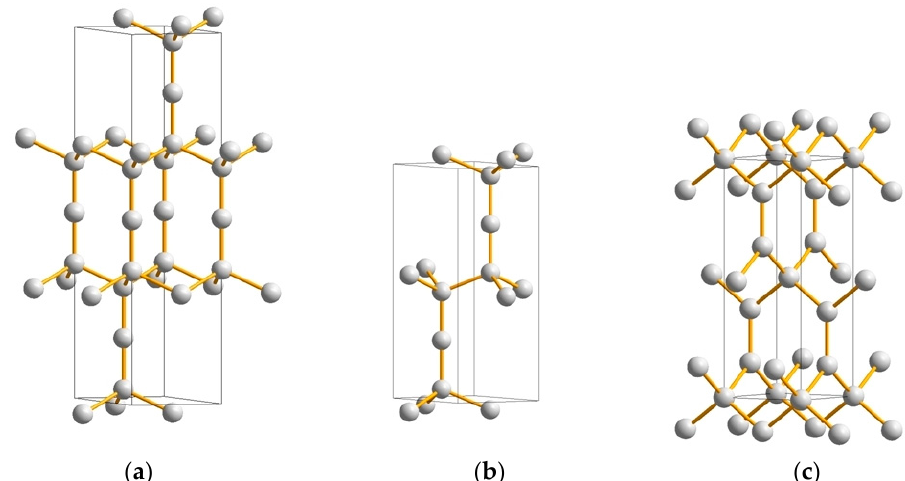
Figure 2. Novel ultrahard carbon allotropes: ‘tricarbons’—rhombohedral C 3 ( a ) and hexagonal C 6 ( b ) (both structures are in hexagonal setting); and tetragonal C 6 ‘neoglitter’ ( c ). The elastic properties of ‘tricarbon’ allotropes rh -C 3 and hex -C 6 were determined by performing finite distortions of their lattices. The elastic constants C ij were derived from the strain–stress relationship. Indexes i and j represent directions: when i = j, the elastic constants correspond to the application of unidirectional stress (as in the case of C 33 elastic constant discussed below), and when i ≠ j, the elastic constants are relevant to applying shear stress. For both allotropes, all calculated C ij values are positive, and their combinations obey the rules pertaining to the mechanical stability of the phases. The bulk ( B V ) and shear ( G V ) moduli were calculated from the elastic constants following the Voigt method [26], based on a uniform